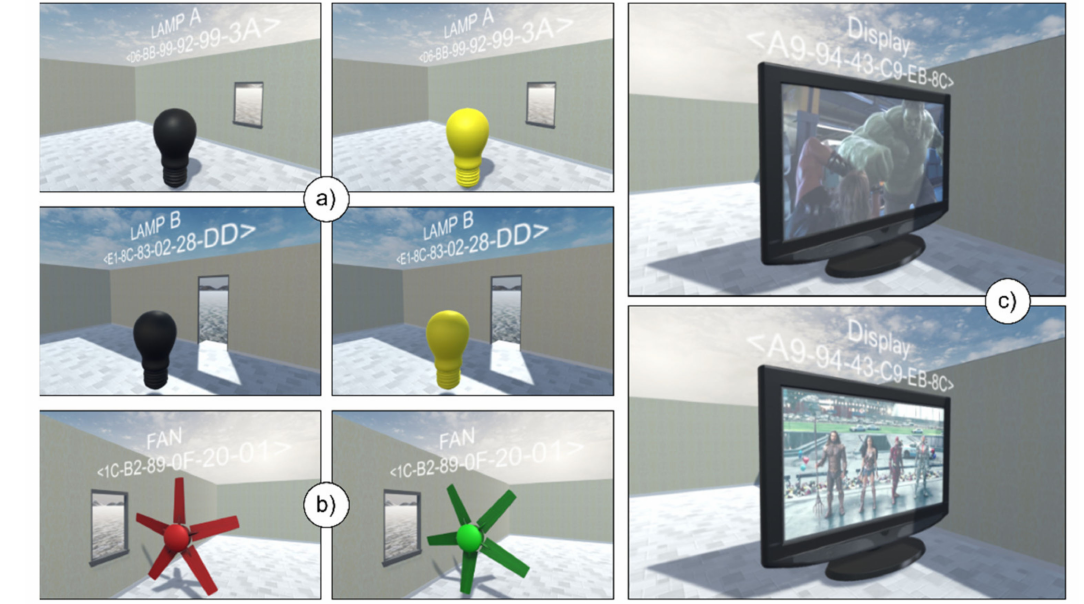
Figure 10. Three-dimensional actuators and sensors in action: the pair of lamps varying from turned off to on are represented by ( a , b ) regards to the fan, in idle state and during rotation; finally, in ( c ), lies the display reproducing different content.